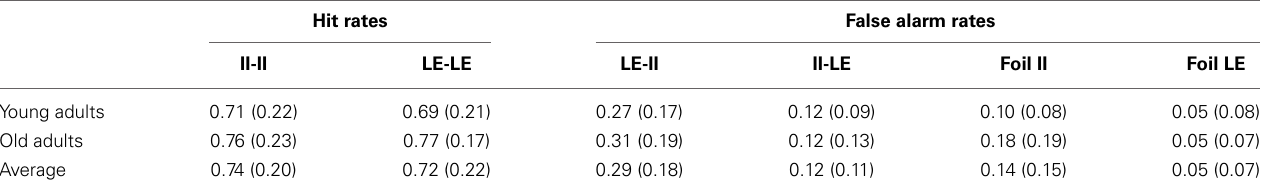
Table 3 | Average proportion of “old” responses as a function of age and item type (Standard deviations in